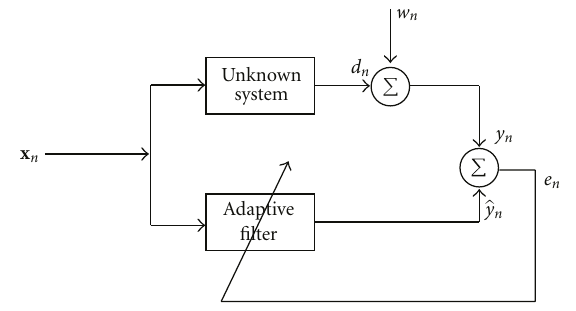
Figure 1: Blockdiagramrepresentation for the proposed algorithm.